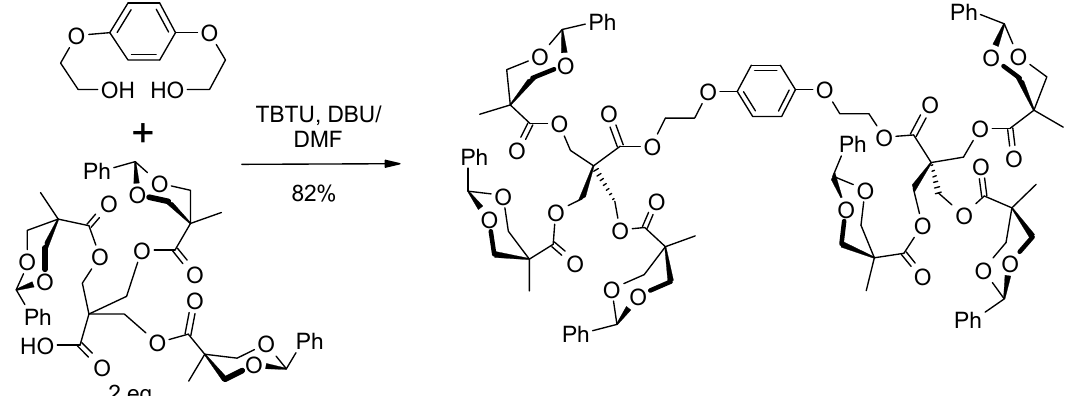
Scheme 10. Use of an uronium-based promoter for ester bond formation in assembly of a second generation dendrimer